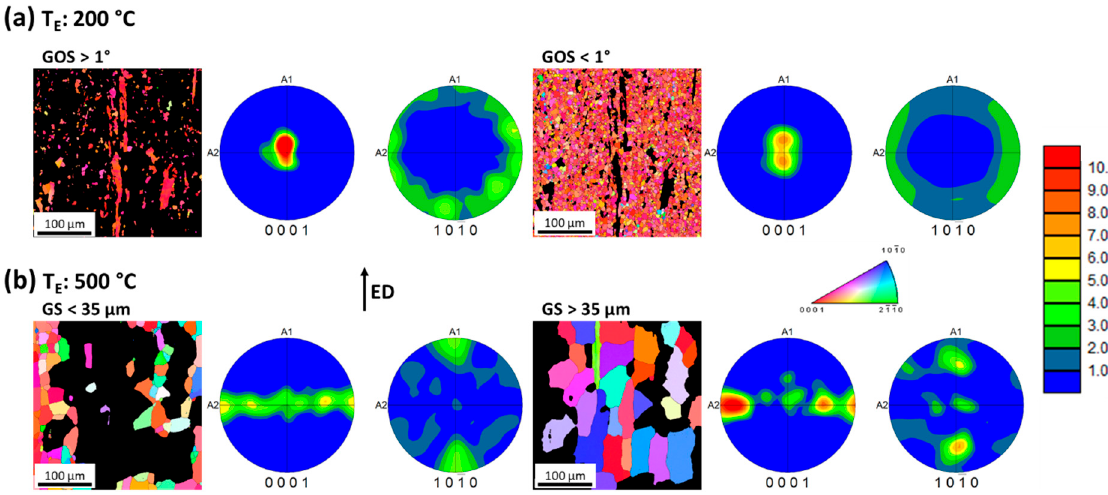
Figure 8. ESBD measurement of AZ31: ( a ) extruded at 200 °C separated by grain orientation spread (GOS); ( b ) extruded at 500 °C separated by the grain size (GS). (GOS); ( b ) extruded at 500 ◦ C separated by the grain size